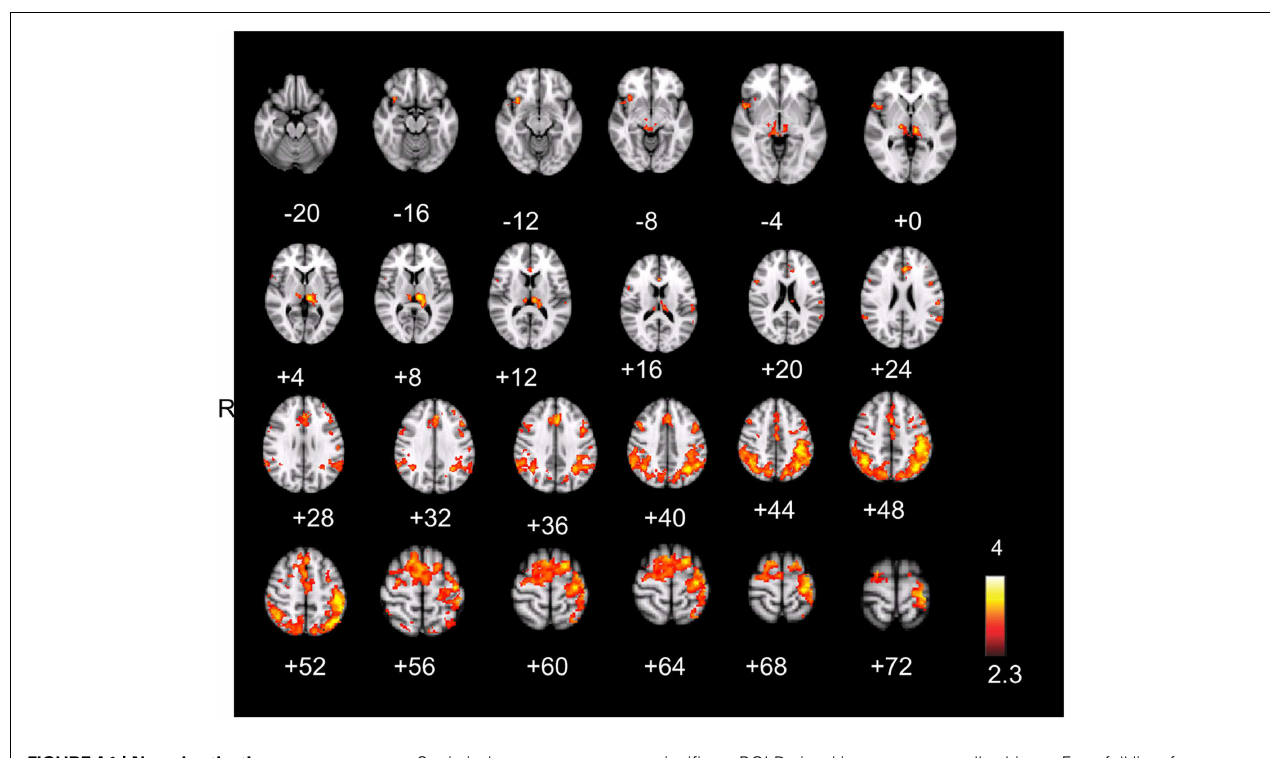
FIGUREA1 | Neural activation on aware errors. Statistical parametrical map of difference in BOLD activation between aware and unaware errors. Red and yellow voxels represent clusters of